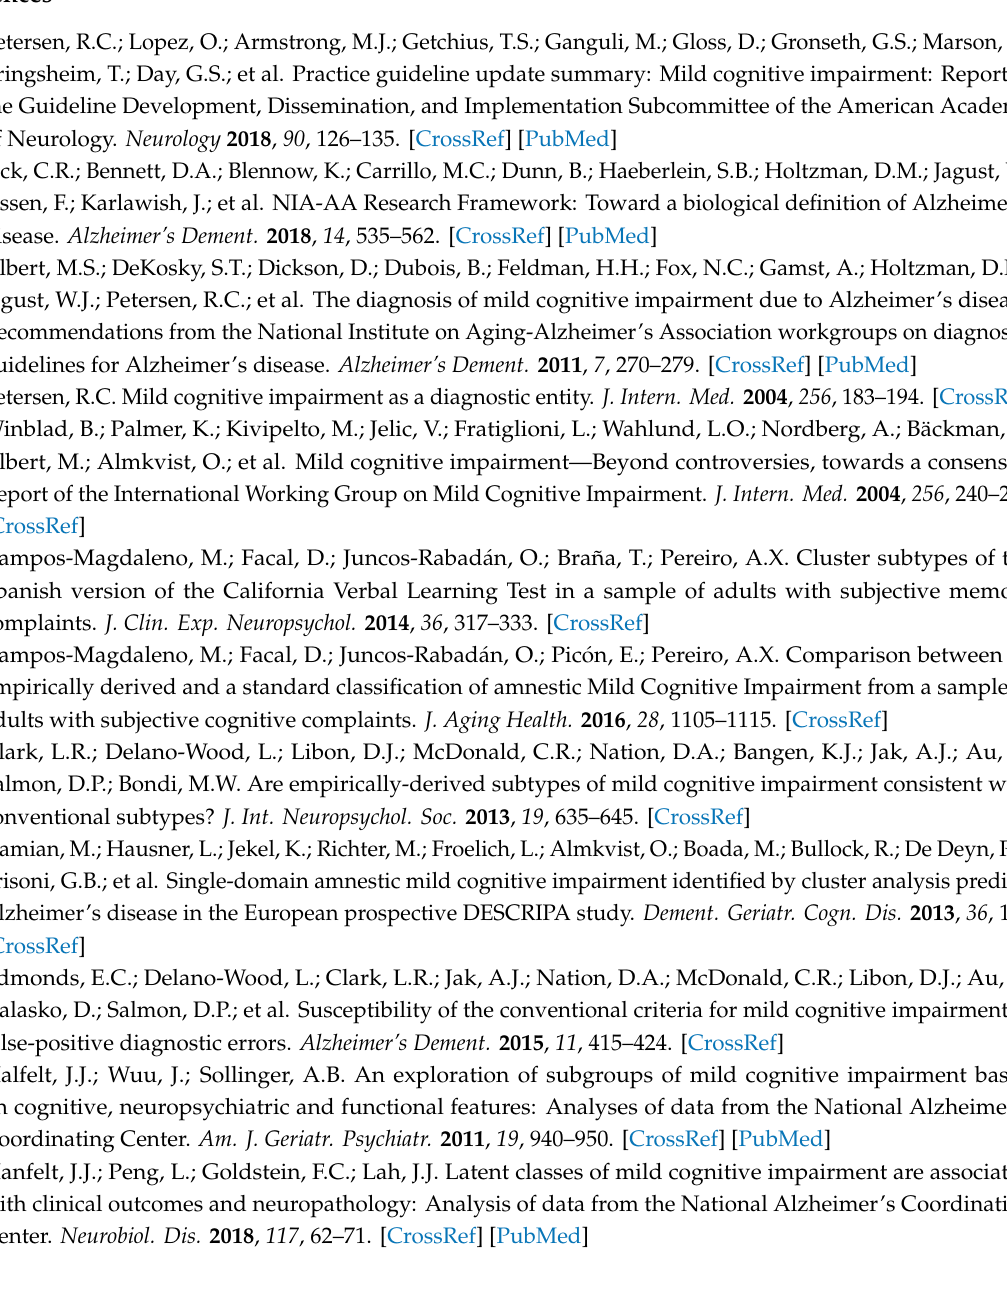
Table S1: Neuropsychological characteristics (raw scores) of variables used for cluster analysis, means and standard deviations in parentheses) and comparisons of the four empirical groups (Cluster 1, Cluster 2, Cluster 3 and Cluster